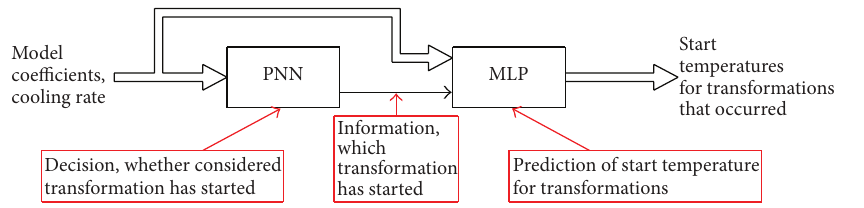
Figure 16: The general idea of using PNN and MLP as phase transformations metamodel.